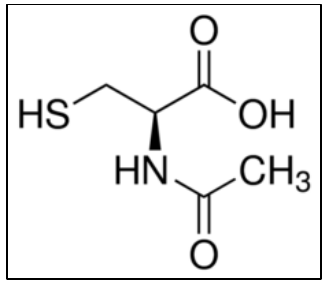
Figure 4. Chemical structure of N -acetyl- L -cysteine (NAC). Table 4. Summary of the potential effects of NAC supported by studies based on clinical trials.